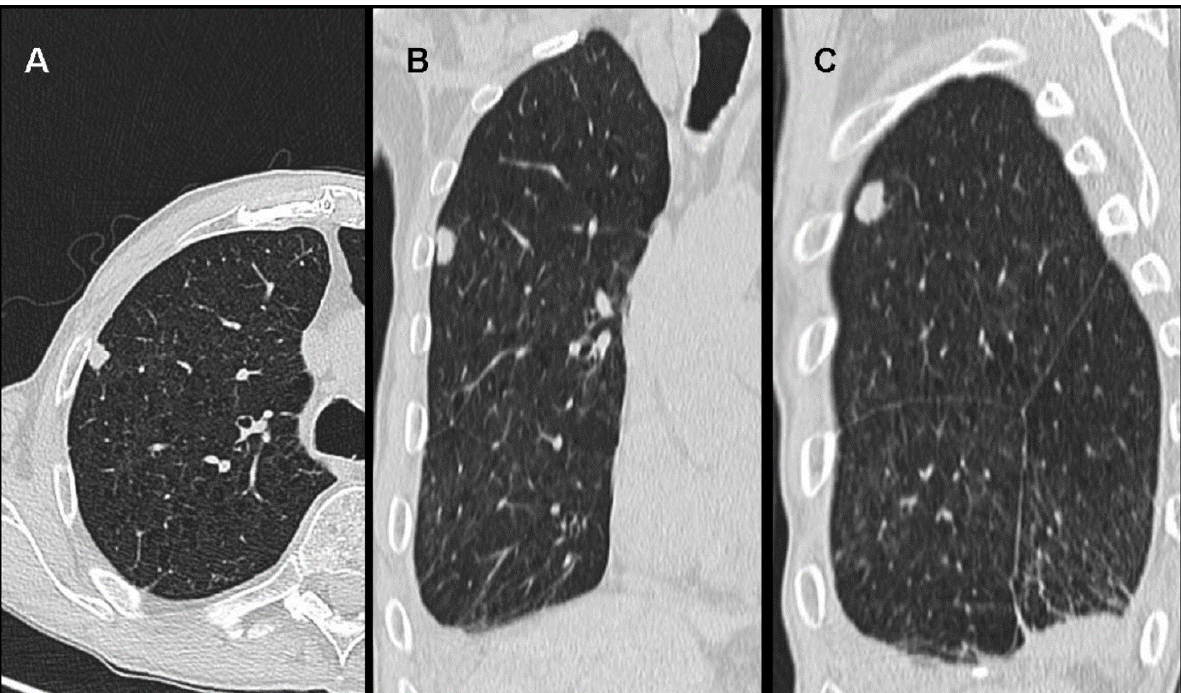
Figure 1. Malignant mesothelioma presenting as a solitary pulmonary nodule of the right upper lobe at the CT Scan in axial ( A ), frontal ( B ) and sagittal ( C ) views.